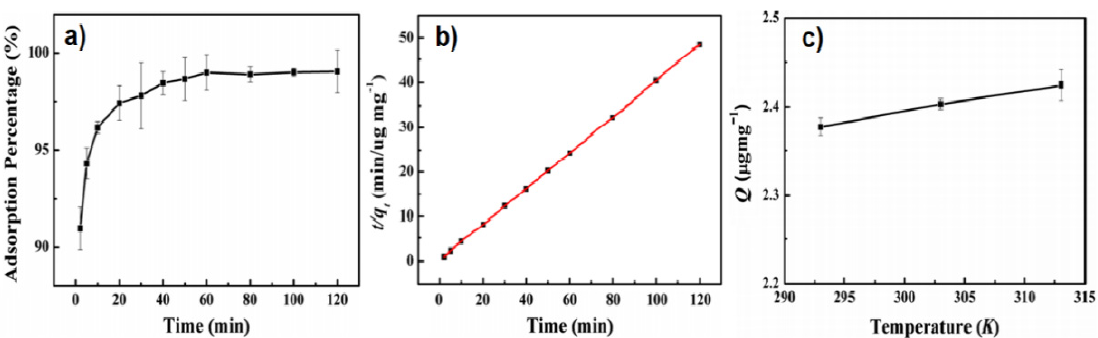
Figure 8. ( a ) Adsorption percentage of BCG onto poly(GMA-MAA-EDMA)-CHT vs time; ( b ) Pseudo-second-order kinetic model plots for the adsorption data reported in ( a ); ( c ) Effect of tem- perature on the adsorption of BCG onto poly(GMA-MAA-EDMA)-CHT. All the shown trends refer to the following conditions: dosage of adsorbent: 10 mg, concentration of BCG: 5 μ g cc − 1 , adsorption time: 40 min, pH 2.0). Adapted from Ref. [93].